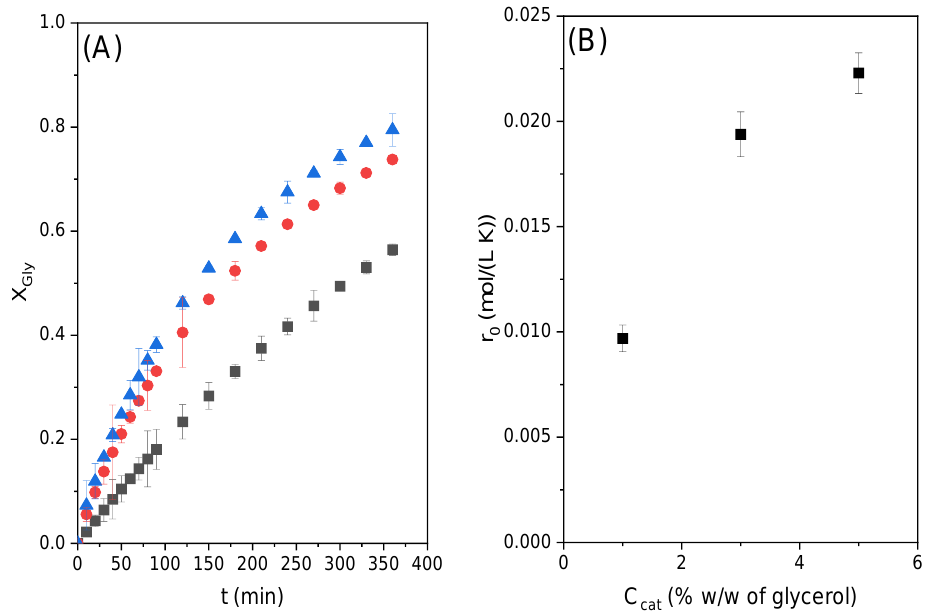
Figure 3. ( A ) Effect of catalyst loading at 80 °C and a CE/Gly ratio of 2 on the conversion of Gly as a function of reaction time with different catalyst loadings, where ◼ represents 1% catalyst loading, ⚫ 3% catalyst loading, and 5% catalyst loading. ( B ) Initial observed reaction rates for these experiments.